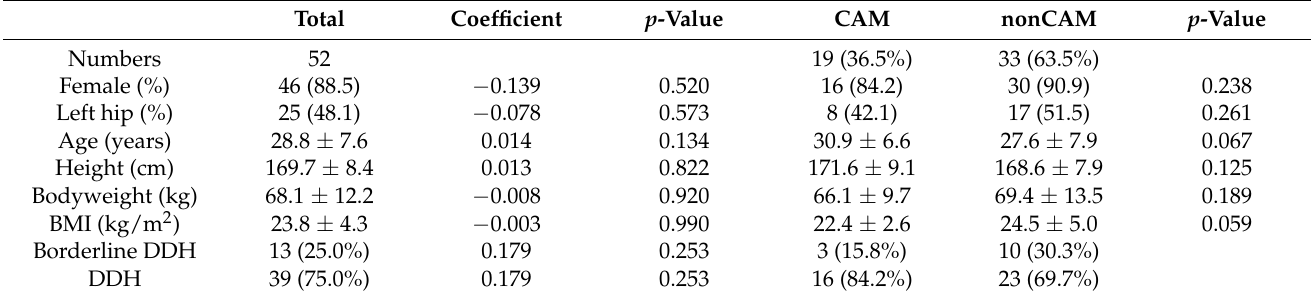
Table 1. Demographics of the individuals presenting with symptomatic hip pain.